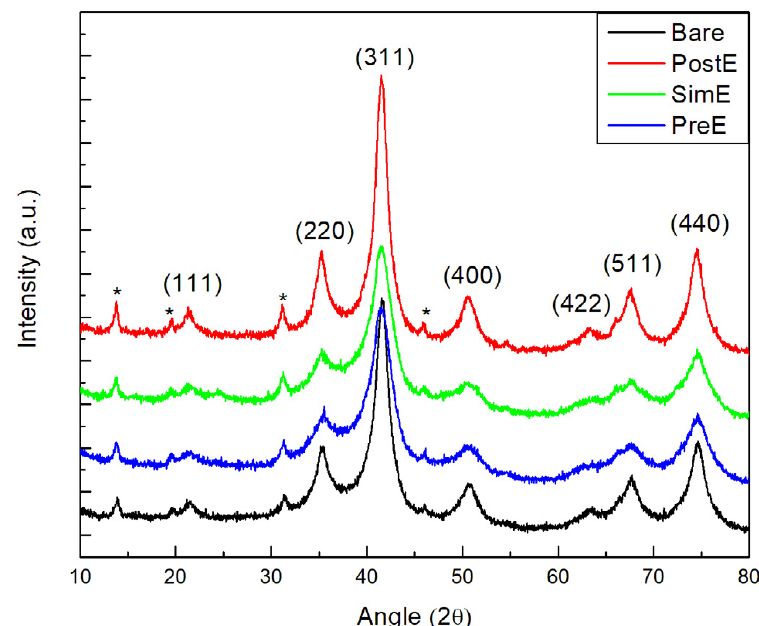
Fig. 5. Powder XRD pattern of the bare nanoparticles, along with the L-glutamic acid series of capped